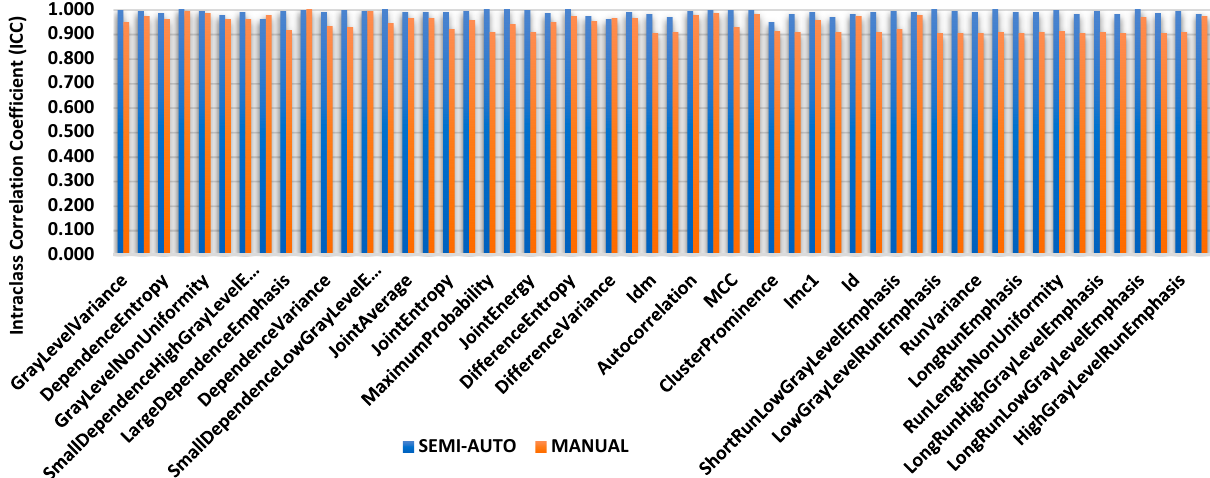
Figure 5. Intra-class correlation coefficient (ICC) comparisons for textural features.